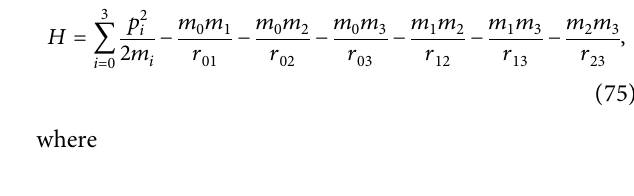
Figure 10: The progressive evolution of a Poincar´e surface of sections for different energy levels in the unequal masses case ( m � 0 . 31, m � m � 1, b � 1 . 1, and c � 0 . m 2 3 1